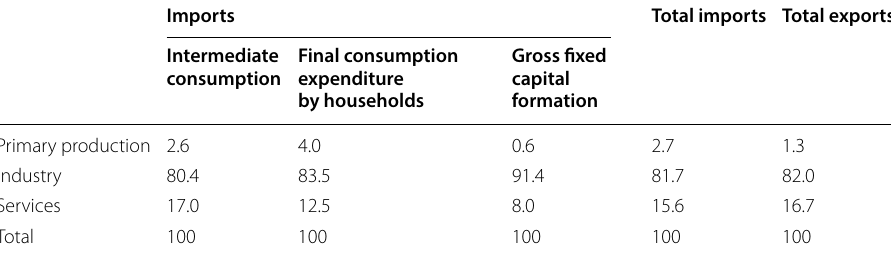
Table 4 Sectoral compositions (%) of imports and exports;